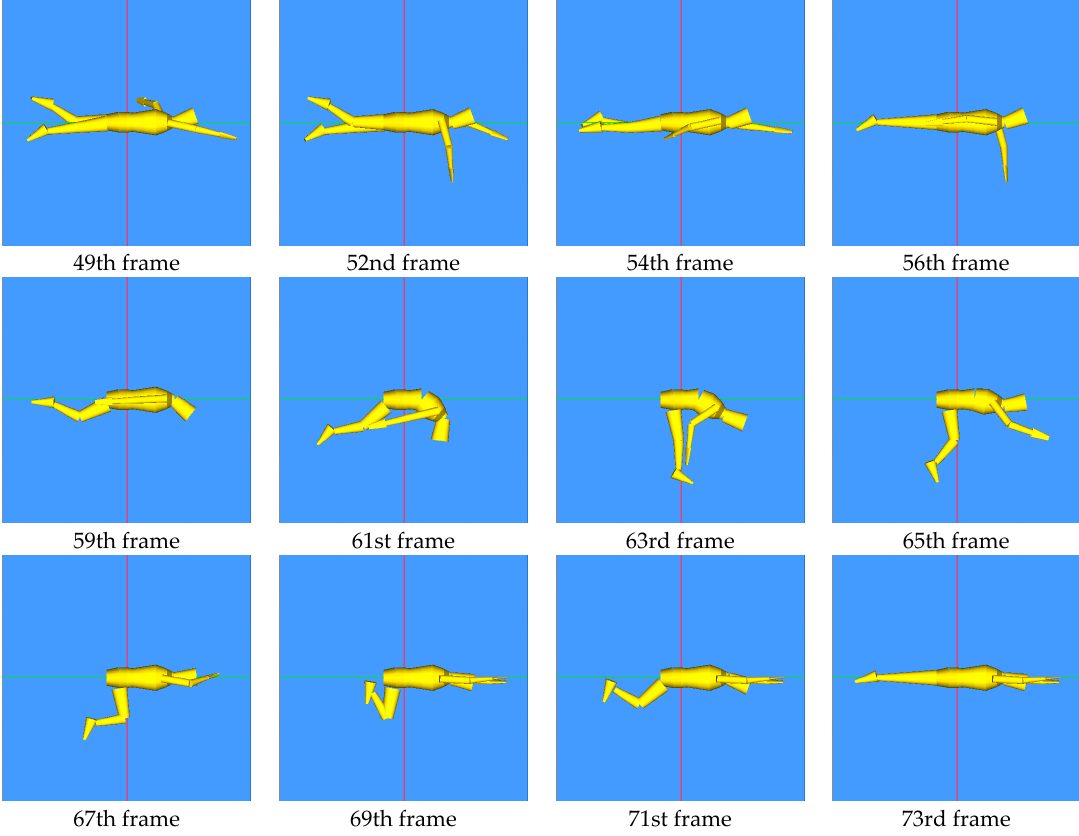
Figure 1. The created joint motion including flip